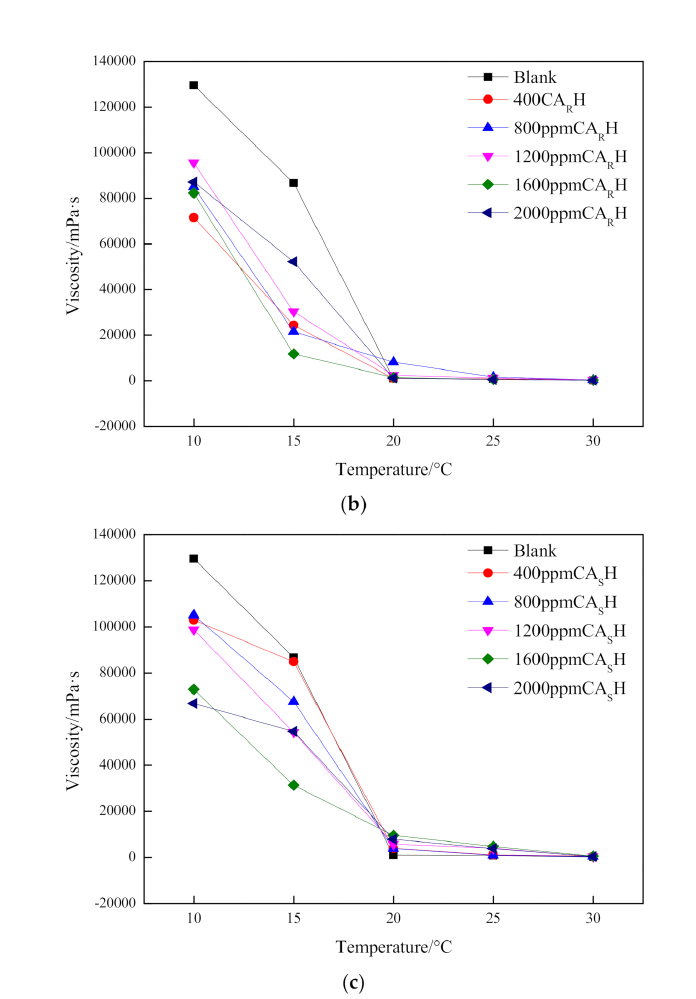
Figure 3. ( a ) Effect of CA C H on the viscosity of XJO crude oil; ( b ) effect of CA R H on viscosity of XJO crude oil; ( c ) effect of CA S H on the viscosity of XJO crude